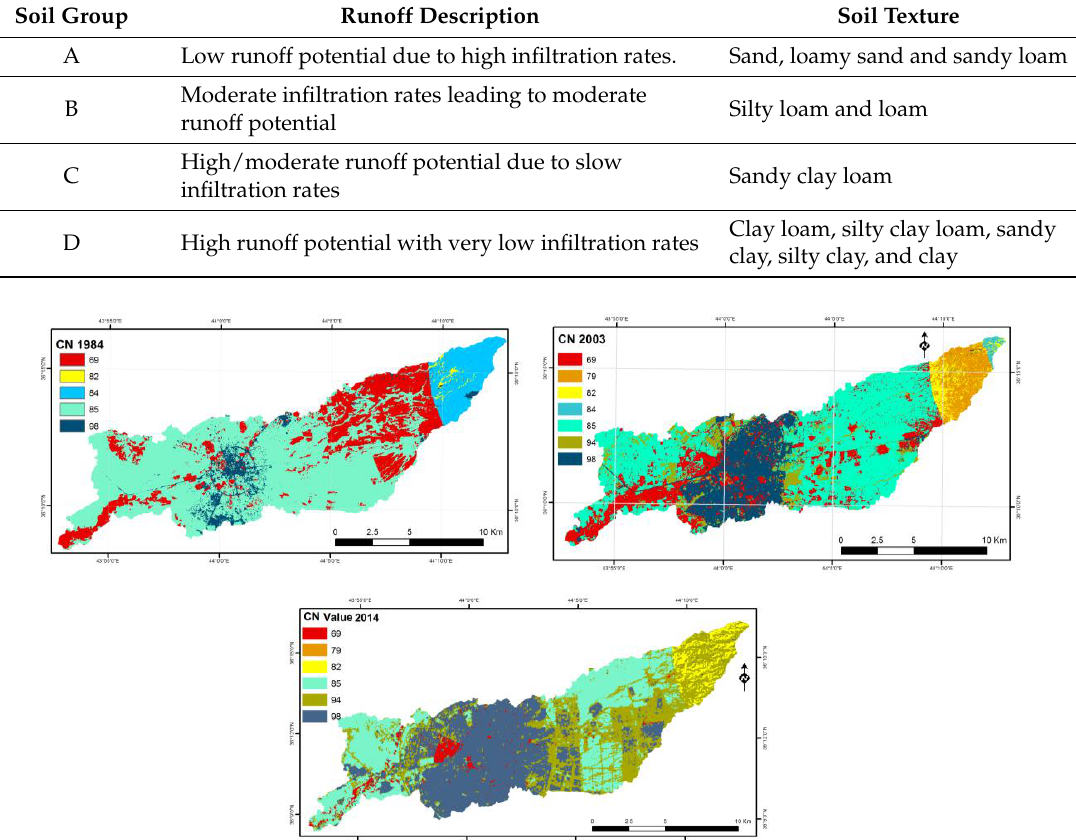
Figure 5. Curve number maps for the years 1984, 2003 and 2014 for the study area. Table 1. Hydrologic Soil Groups and corresponding soil texture. From: [36].